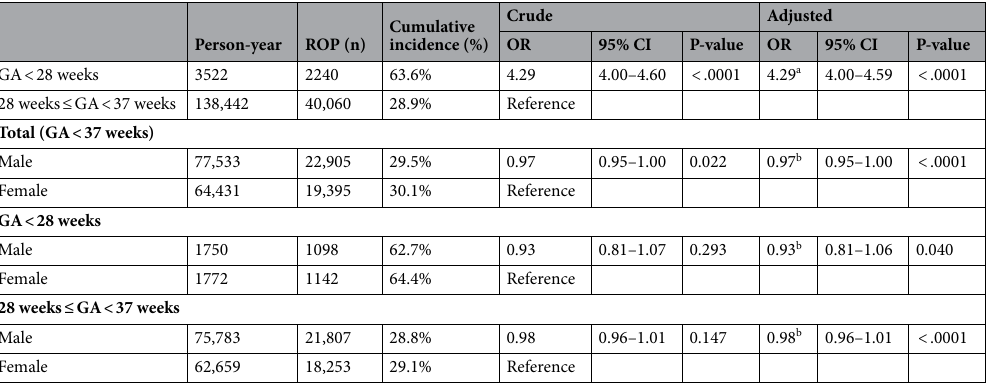
Table 2. The odds ratios (OR) of incidence of retinopathy of prematurity according to gestational age and sex during the 12-year study period. OR was estimated using logistic regression analysis. GA gestational age, ROP retinopathy of prematurity. a OR adjusted for sex, year of diagnosis, income level, area of residence. b OR adjusted for year of diagnosis, income level, area of